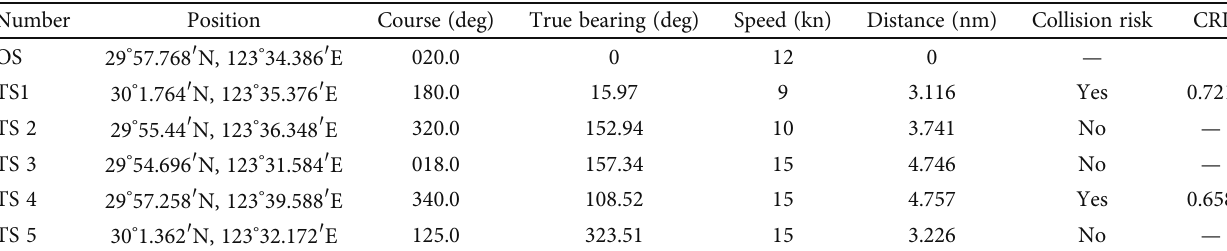
Table 5: The initial information and risk results of